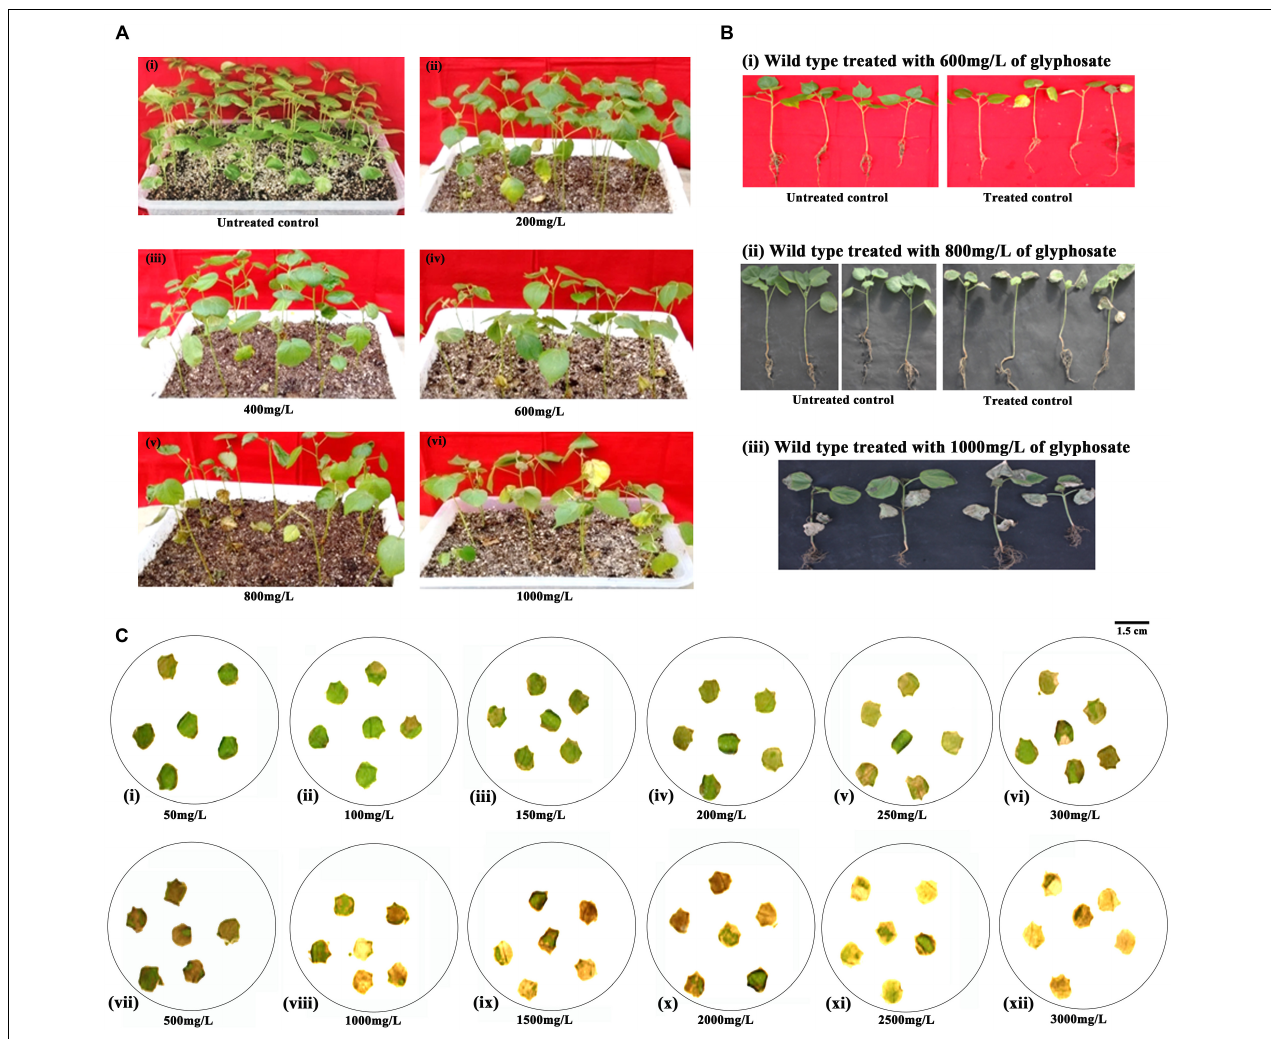
FIGURE 2 | Standardization of glyphosate tolerance assays in cotton cv. P8-6 at seedling and plant level. (A) Standardization of glyphosate concentration to be sprayed at seedling level: (i) untreated control; seedlings sprayed with different concentrations of glyphosate, (ii) 200 mg/L, (iii) 400 mg/L, (iv) 600 mg/L, (v) 800 mg/L, (vi) 1,000 mg/L. (B) (i–iii) Response of the cotton seedlings to different glyphosate concentrations 7–8 days after the spray. (C) Standardization of glyphosate concentration in leaf disc assay (i) 50 mg/L, (ii) 100 mg/L, (iii) 150 mg/L, (iv) 200 mg/L, (v) 250 mg/L, (vi) 300 mg/L, (vii) 500 mg/L, (viii) 1,000 mg/L, (ix) 1,500 mg/L, (x) 2,000 mg/L, (xi) 2,500 mg/L, (xii) 3,000